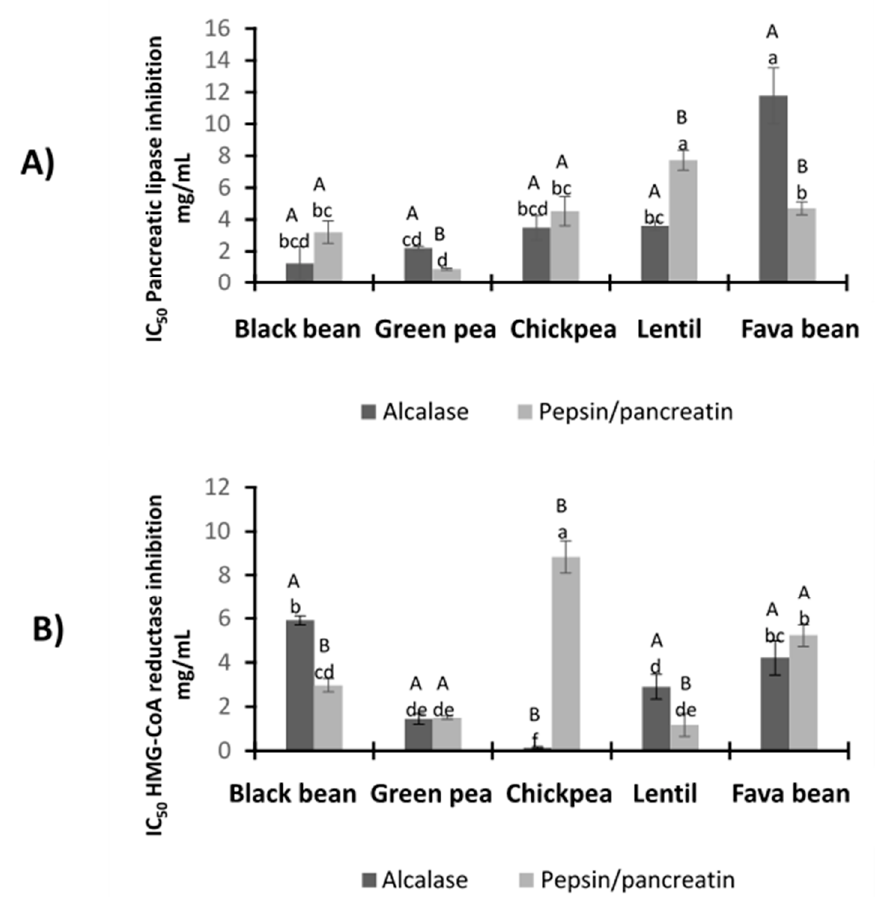
Figure 4. ( A ) Inhibition potential of LPH to pancreatic lipase (IC 50 mg/mL). Orlistat synthetic inhibitor IC 50 = 2.73 µg/mL [31]. Different capital letters indicate significant differences between alcalase and pepsin/pancreatin digestion ( p < 0.05); different lowercase letters indicate significant differences ( p < 0.05) among legume protein hydrolysates. ( B ) Inhibition potential of LPH to HMG-CoA (IC 50 mg/mL). Simvastatin synthetic inhibitor IC 50 = 0.08 µg/mL. Different capital letters indicate significant differences between alcalase and pepsin/pancreatin digestion ( p < 0.05); different lowercase letters indicate significant differences ( p < 0.05) among legume protein hydrolysates. Results represent the mean ± SD of at least two independent experiments.